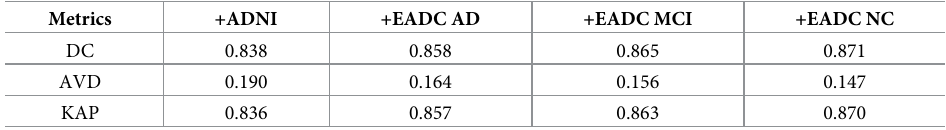
Table 7. Mean results of the incremental experiment with our system.